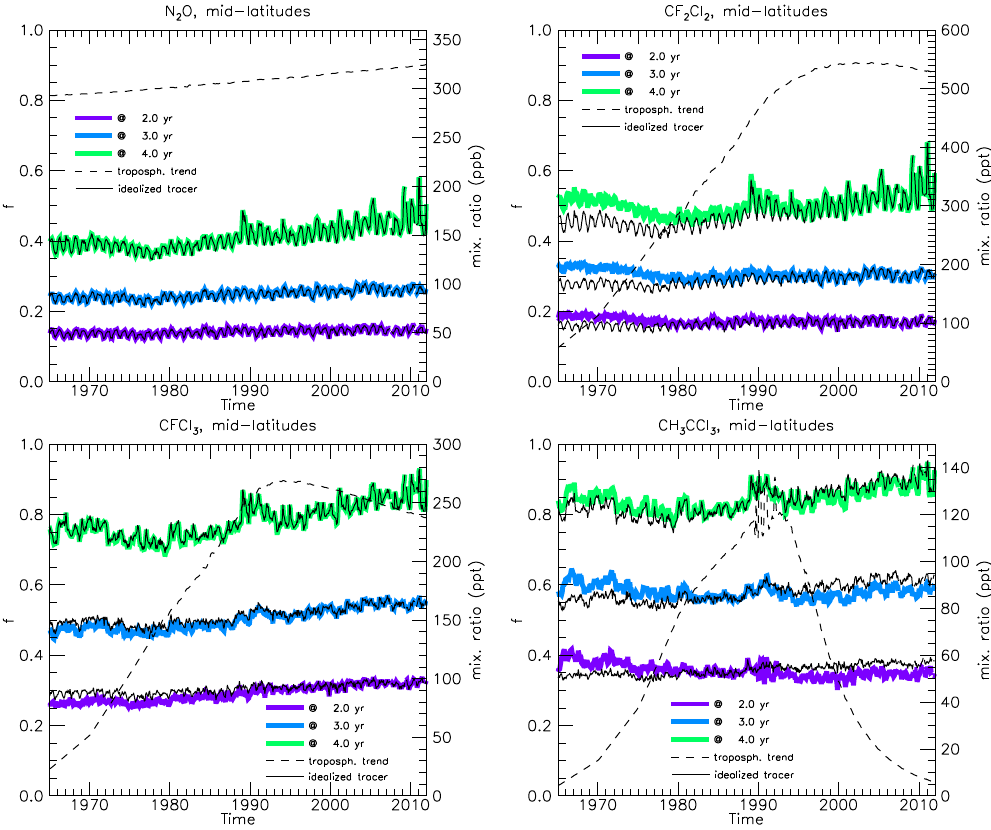
Figure 4. Temporal evolution of FRF calculated by the new formulation, taking into account chemical loss. The results of the realistic tracers are shown in colour on different age isosurfaces. The results of the idealized tracers are shown in solid black lines, whereas the tropospheric trend is plotted in dashed lines. We find much better agreement between idealized and realistic tracers compared to the current formulation of FRF (cf. Fig.